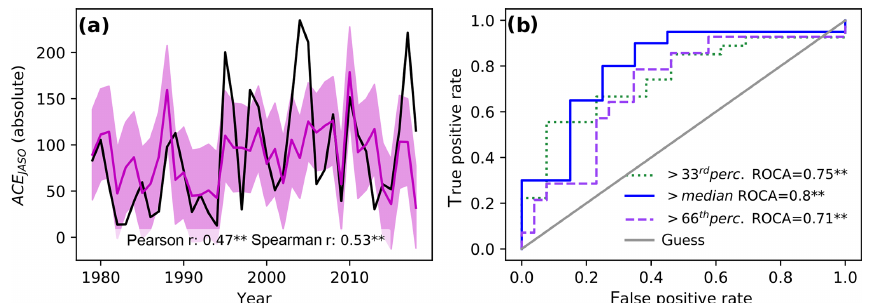
Figure 5. Hindcast skill based on May reanalysis. (a) ACE yearly aggregated over July–October (black) and based on our linear forecast model using precursors identified for the month of May (magenta). The shading corresponds to a 66% confidence interval based on the standard deviation of the model over the training periods. (b) Receiver operating characteristic (ROC) curve (see Supplement) for different seasonal activities: above the (long-term) median in blue, above the 33rd percentile in green and above the 66th percentile in purple. The area under the ROC curve (ROCA) is indicated in the legend with significance levels ( ∗∗ – alpha = 0.05; ∗ – alpha = 0.1).